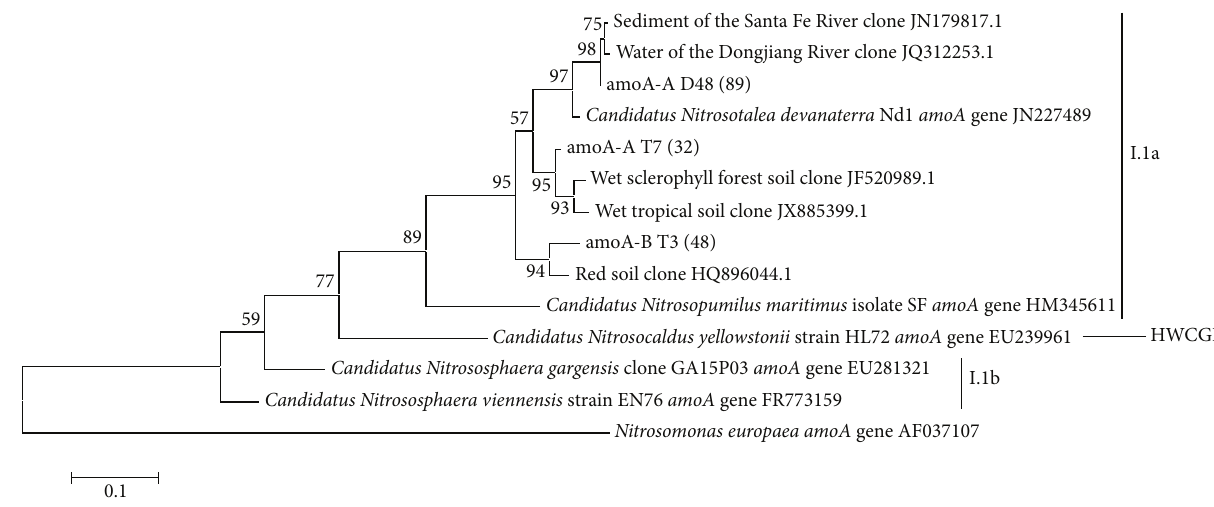
Figure 5: Phylogenetic tree of archaeal amoA OTUs (90%) obtained from Cerrado freshwater sediments in the dry season (amoA-A D and amoA-B D sequences) and in the dry to rainy season transition period (amoA-A T and amoA-B T sequences). The number of sequences that are represented by a specific node of the tree is indicated in parenthesis. The phylogenetic tree was inferred by the maximum-likelihood method using the MEGA software, bootstrap value of 1,000, and Tamura-Nei nucleotide substitution model. The percentage of bootstrap resamplings that supports each topological element is represented near the line. Reference sequences from different archaeal amoA genes were used for comparison and the bacterial sequence Nitrosomonas europaea amoA gene AF037107 was used as an outgroup. Bootstrap values below 50 were not shown and singletons were not